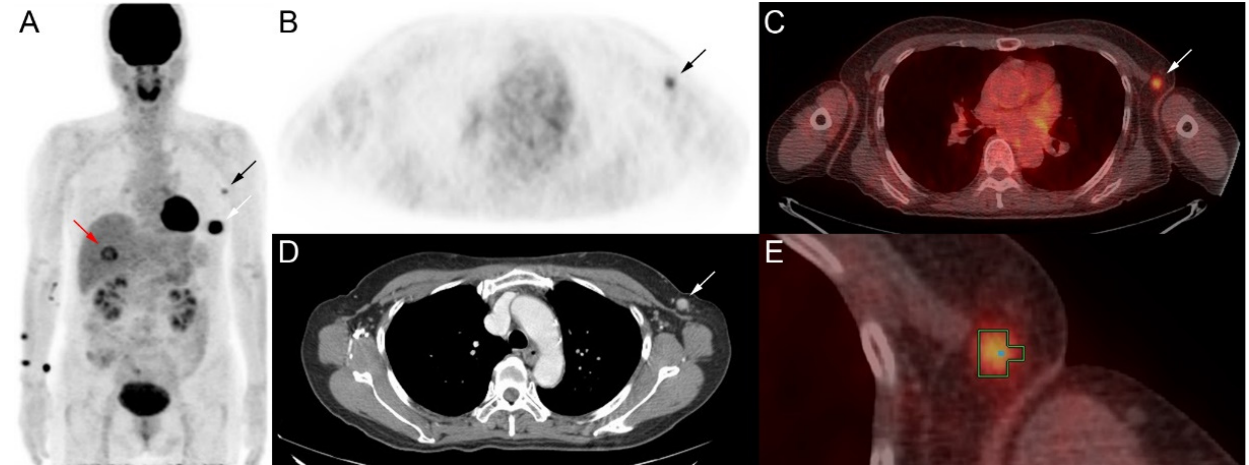
Figure 2. A 60-year-old woman with invasive ductal carcinoma of the left breast. The patient had biopsy-proven metastases of the left axillary lymph node and liver. Maximum intensity projection image of 18 F-fluorodeoxyglucose positron emission tomography ( 18 F-FDG PET) ( A ) shows abnor- mally increased 18 F-FDG uptake in the left breast (white arrow), left axilla (black arrow) and liver (red arrow). Trans-axial PET image ( B ), fused positron emission tomography/computed tomography (PET/CT) image ( C ), and contrast-enhanced CT image ( D ) show an enlarged lymph node with increased 18 F-FDG uptake in the left axilla (arrows). Volume of interest was drawn around the left axillary lymph node with a threshold of 50% maximum standardized uptake value on fused PET/CT image ( E ). The maximum standardized uptake value and total lesion glycolysis of the left axillary node were 2.51 and 1.16, respectively. The patient survived without progression during the follow- up period of 33 months.